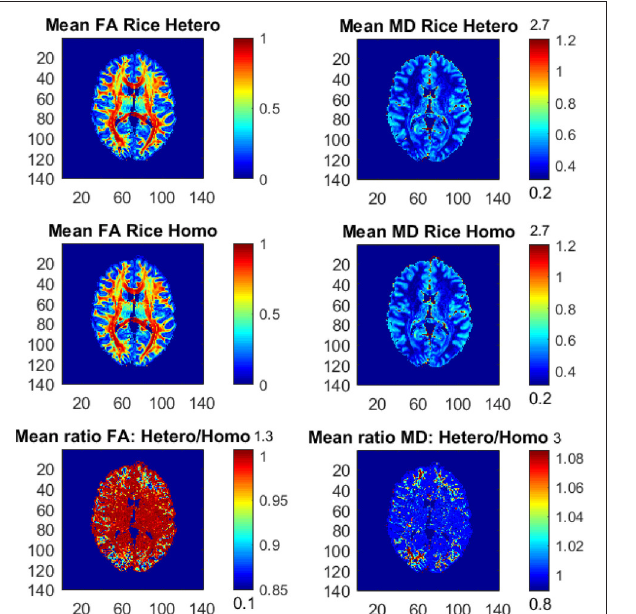
FIGURE 3 | Posterior means and ratios of posterior means of FA and MD for the heteroscedastic (Hetero) and homoscedastic (Homo) Rician DTI models, using the whole dataset with all b- values up to b = 10,000 s/mm 2 . The color bars are shown for the mid 95% values and the minimum and maximum values are marked out at the bottom and top of the color bars, respectively.